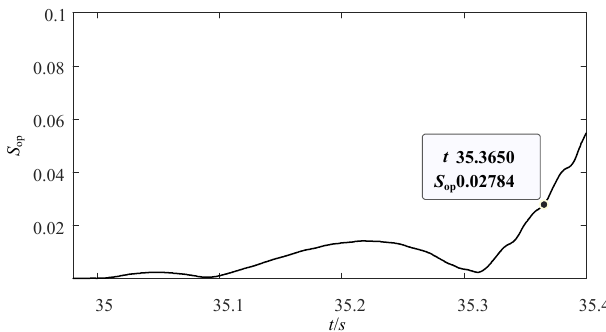
Figure 8. The action of the protection when the slip ratio s is 0.01.